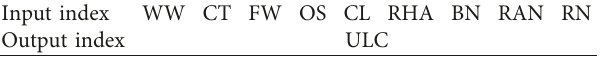
Table 4: Mapping relation of input and output indicators of the prediction model.